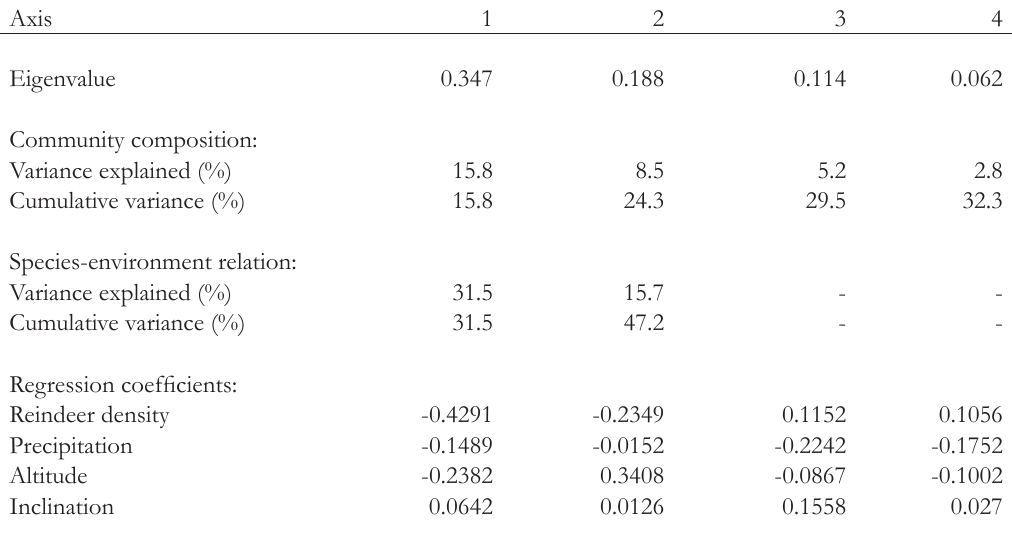
Table 2. Eigenvalues and variance explained by the first four axes in the DCA analyses and regression coefficients between environmental variables and the 4